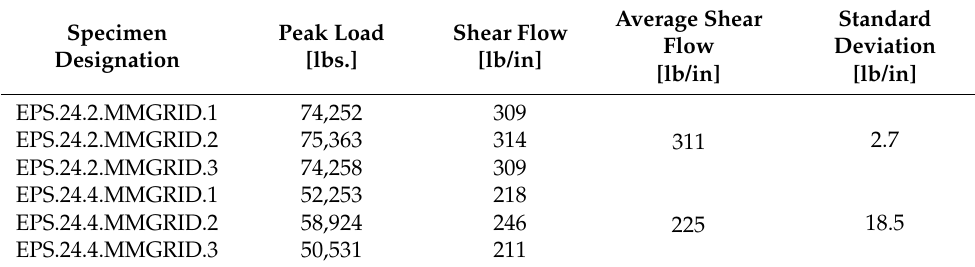
Table 3. Summary of